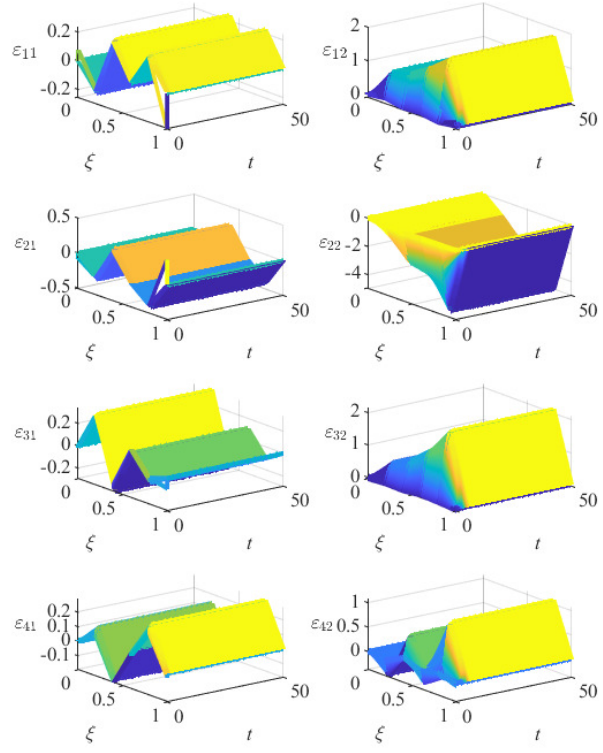
Figure 4. ε i ( ξ , t ) with the control gains d = 0.49 and k = 0 in Example 1.